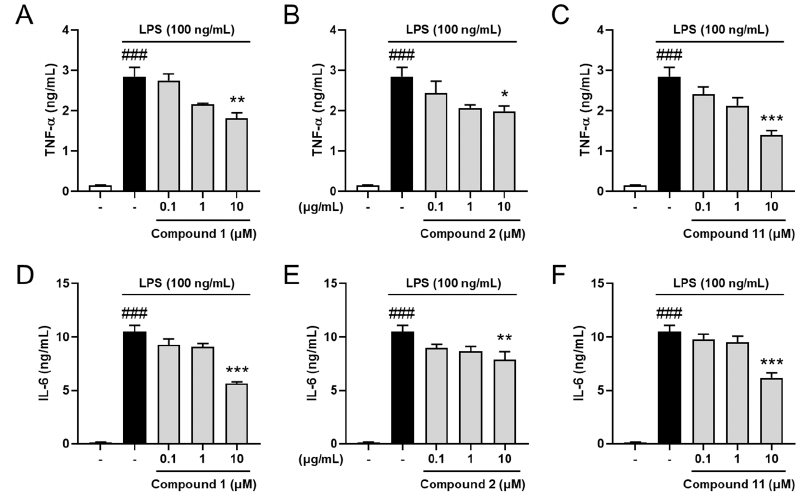
Figure 5. Effects of compounds 1 , 2 , and 11 on pro-inflammatory cytokine release in LPS-stimulated BV-2 cells. The cells were pre-treated with compounds 1 ( A , D ), 2 ( B , E ), or 11 ( C , F ) for 1 h before LPS treatment. At 23 h after LPS stimulation, the supernatants were collected, and TNF- α ( A – C ) and IL-6 ( D – F ) were measured using ELISA kits. Control group, vehicle-only-treated group (white bar); LPS-treated group (black bar); LPS with compounds-treated groups (gray bars). Values are indicated as the mean ± SEM. Data were analyzed by one-way ANOVA, followed by Tukey’s post-hoc test. ### p < 0.001 compared with the control group; * p < 0.05, ** p < 0.01, and *** p < 0.001 compared with the LPS-only-treated group.